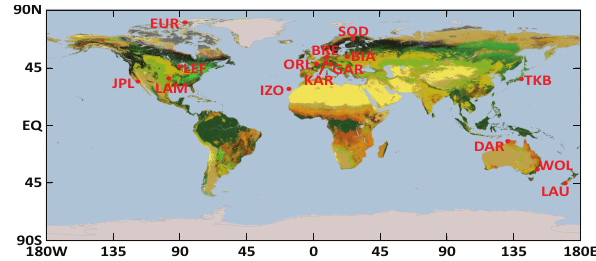
Fig. 1. Locations of TCCON sites (red dots) superimposed on the landcover map (greenish and brownish colors denote intense and weak annual total vegetation activity, respectively; source: www.nasa.gov/vision/earth/environment/urban \ effects.html). The full site names and locations can be found in Sect. 2 and Table 1.